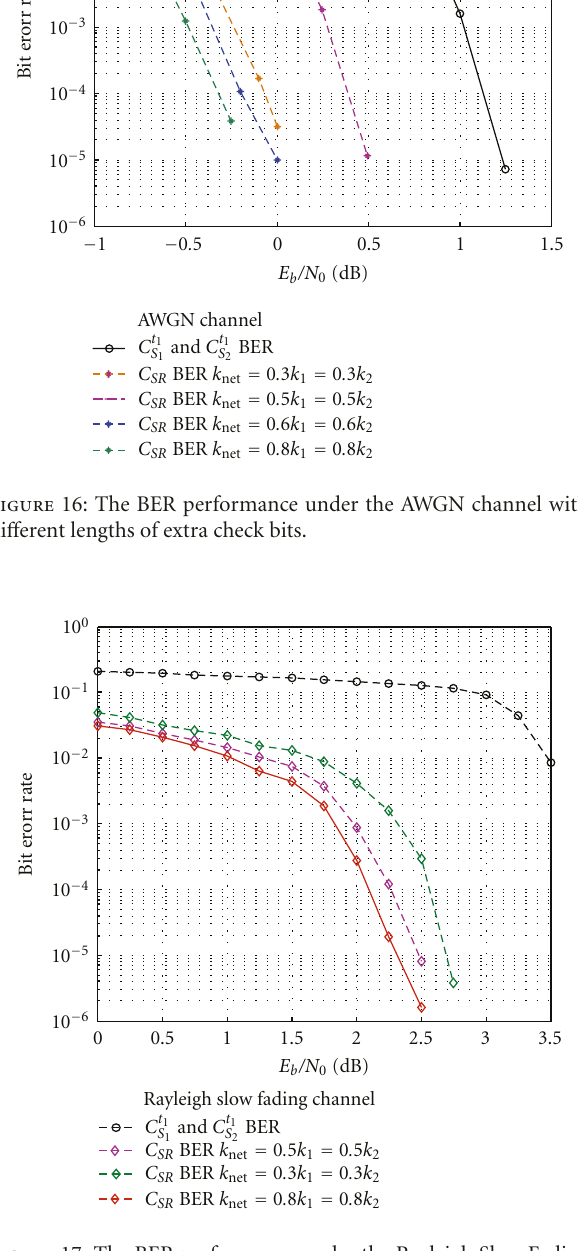
Figure 17: The BER performance under the Rayleigh Slow Fading channel with di ff erent lengths of extra check bits.